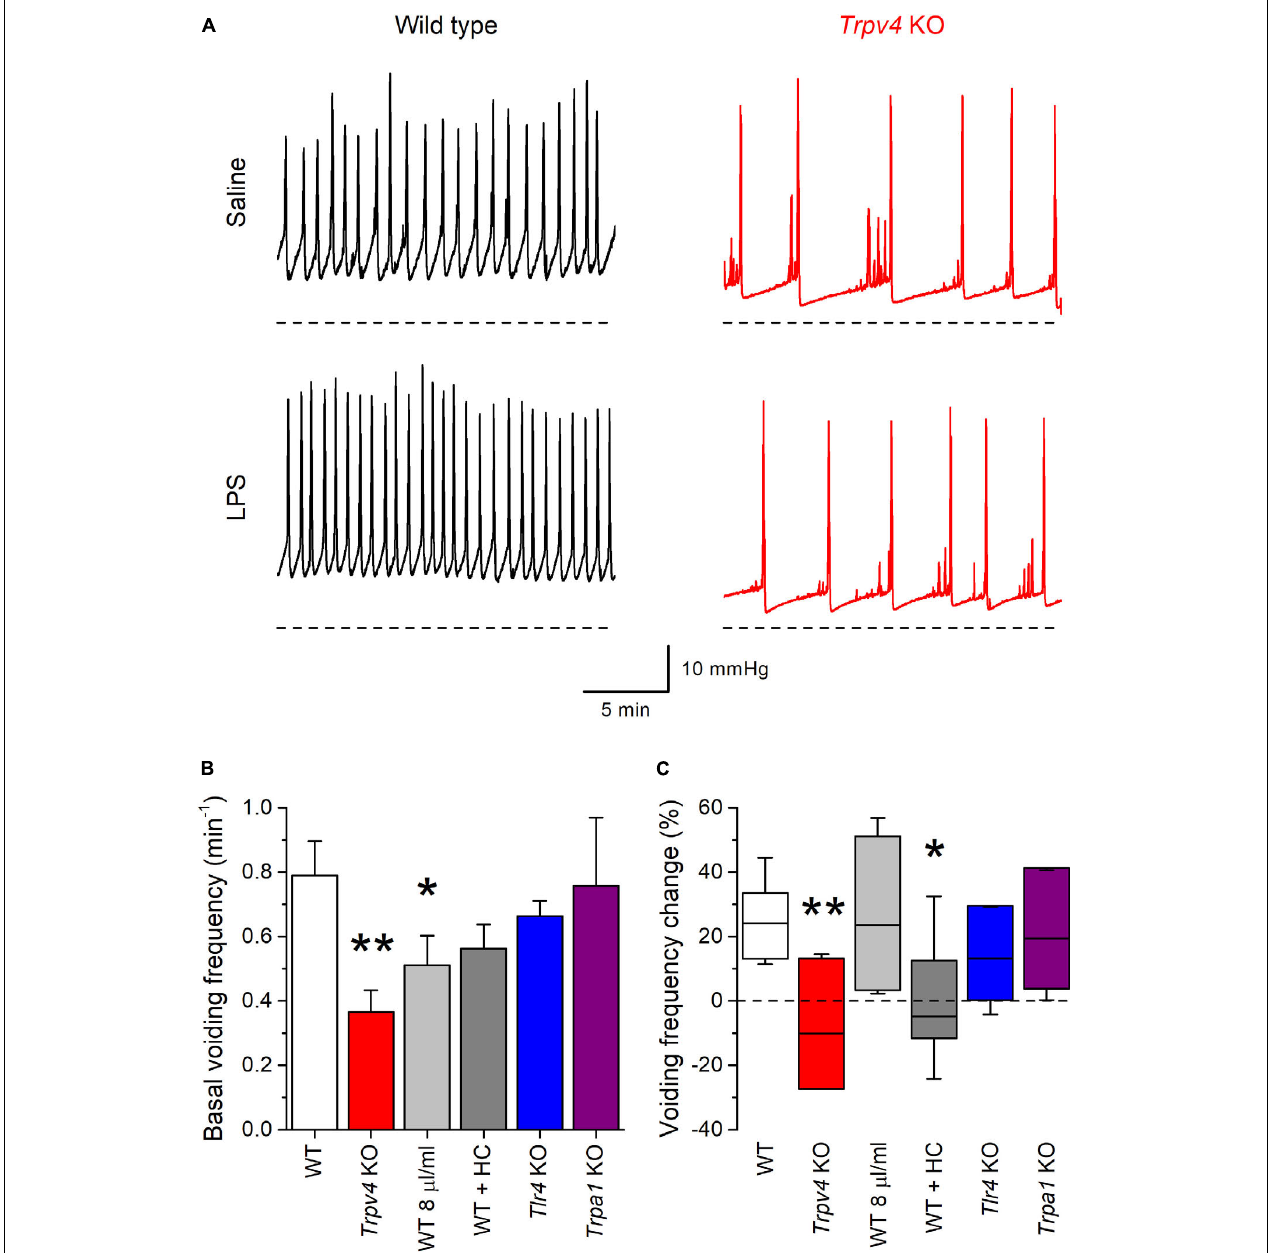
FIGURE 7 | TRPV4 mediates the increase of mouse bladder voiding frequency induced by intravesical instillation of E. coli LPS. (A) Traces of intravesical pressure recordings performed in wild type (black) and Trpv4 KO (red) mice, during infusion of control saline (NaCl 0.9%) or E. coli LPS (200 µ g/ml). (B) Basal voiding frequency of WT ( n = 14), Trpv4 KO ( n = 9), WT perfused at a slow rate of 8 µ l/min ( n = 8), WT administered the TRPV4 inhibitor HC-067047 (HC, 2.35 mg/kg, n = 6), Tlr4 KO ( n = 9) and Trpa1 KO ( n = 7) mice. The data is presented as mean ± SEM. The * and ** symbols indicate P < 0.05 and P < 0.01, respectively with a Mann–Whitney U test vs. WT. (C) Change in the voiding frequency determined over 20 min after the first 10 min of intravesical instillation of E. coli LPS (200 µ g/ml). The data is represented as the median (black line), the 25–75 percentiles (box) and the 95% confidence interval (whiskers). The * and ** symbols indicate P < 0.05 and P < 0.01, respectively with a Mann–Whitney U test vs. WT. WT ( n = 13), Trpv4 KO ( n = 9), WT perfused at a slow rate of 8 µ l/min ( n = 7), WT administered the TRPV4 inhibitor HC-067047 (HC, 2.35 mg/kg, n = 6), Tlr4 KO ( n = 9), and Trpa1 KO ( n =